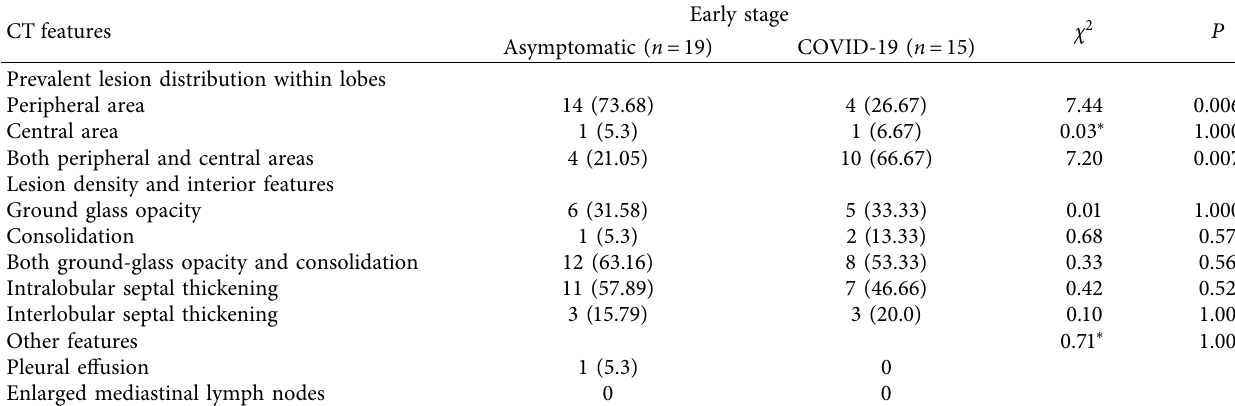
Table 3: Imaging of asymptomatic carriers and COVID-19 patients in the early stage [ n (%)]. CT features